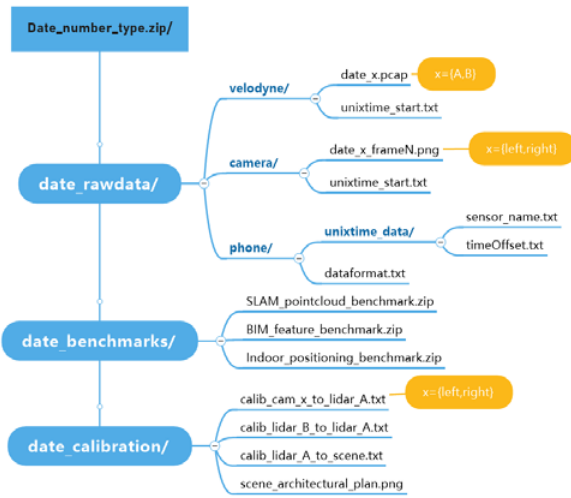
Figure 2. Structure of the dataset. Here, ‘date’, ‘number’, ‘unixtime’, ‘sensor_name’, ‘scene’ and ‘type’ are placeholders. The ‘date_x. pacp’ refers to the two LiDAR streams, and ‘date_x.mp4' refers to the two video camera streams.